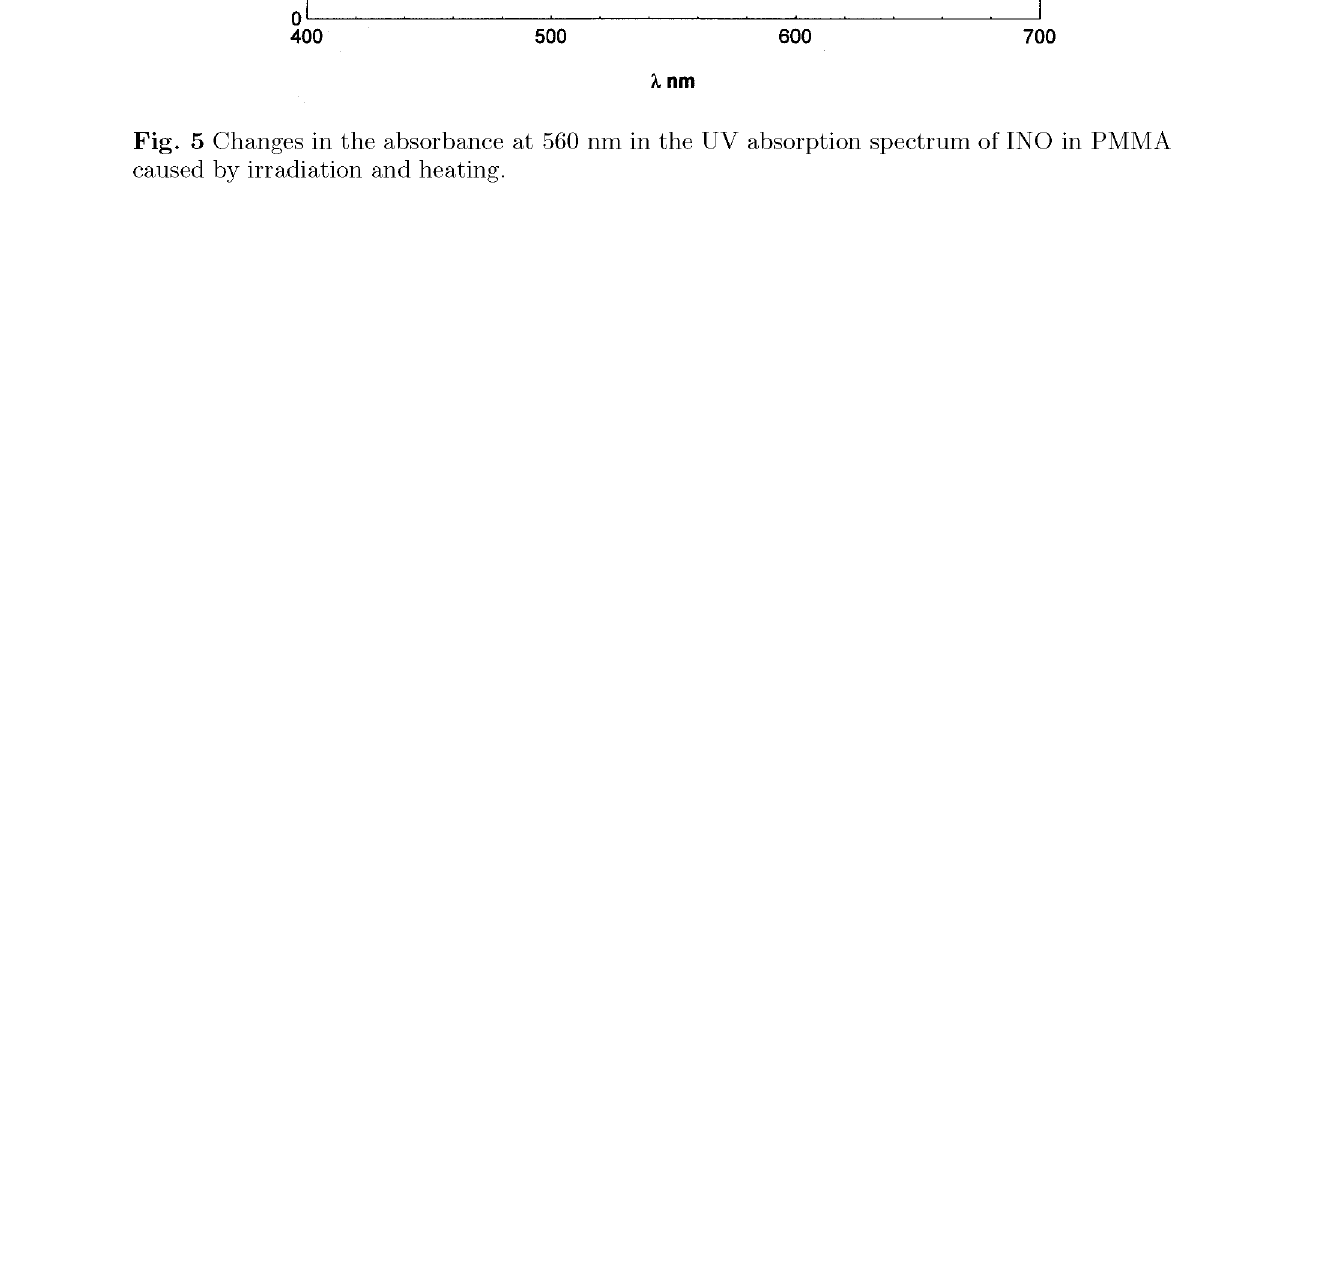
Fig. 5 Changes in the absorbance at 560 nm in the UV absorption spectrum of INO in PMMA caused by irradiation and